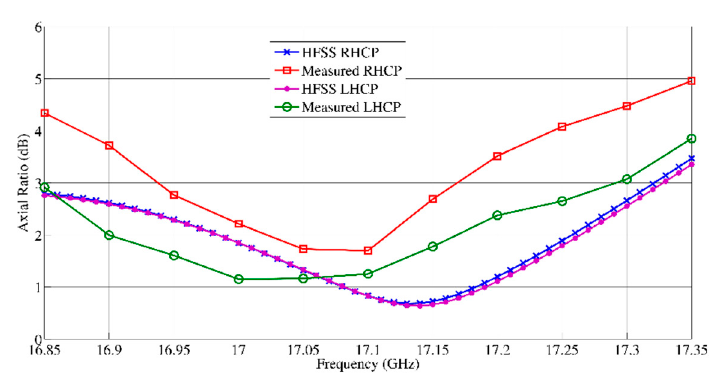
Figure 2. Simulated and measured axial ratio of the two implemented patch arrays vs frequency.